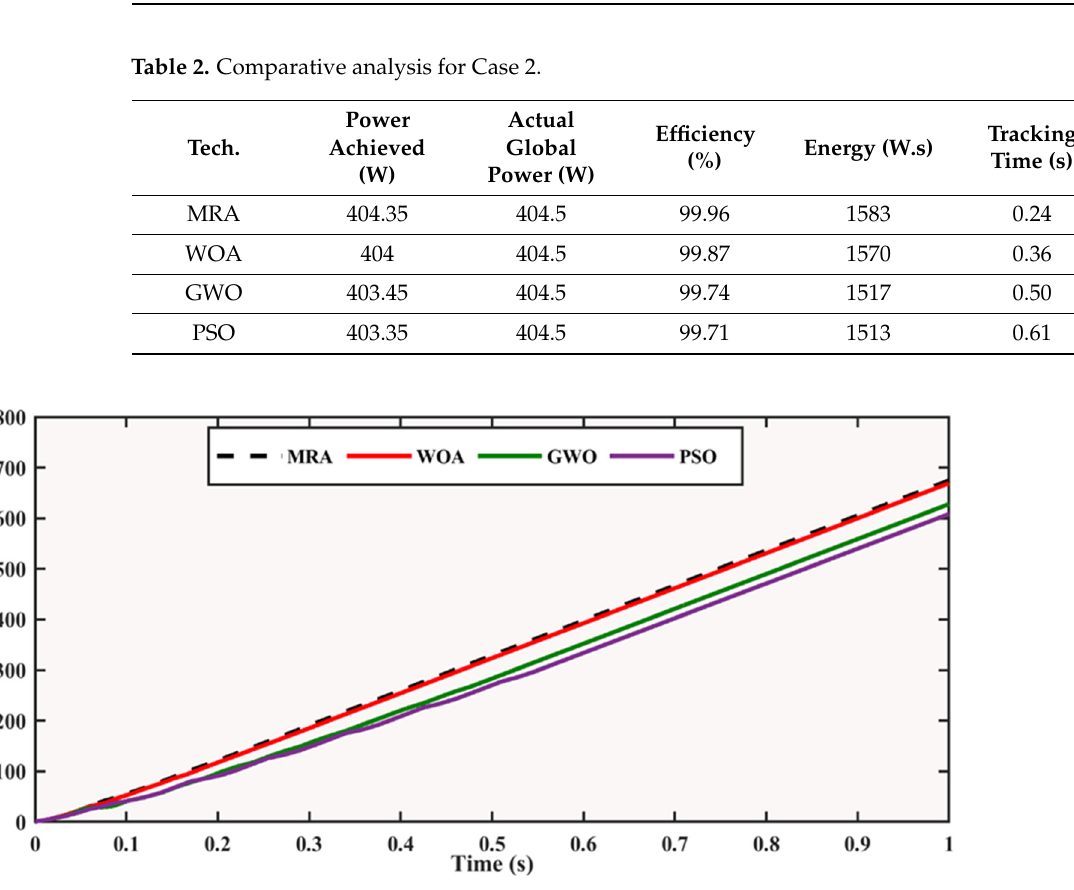
Figure 8. Energy comparison Case